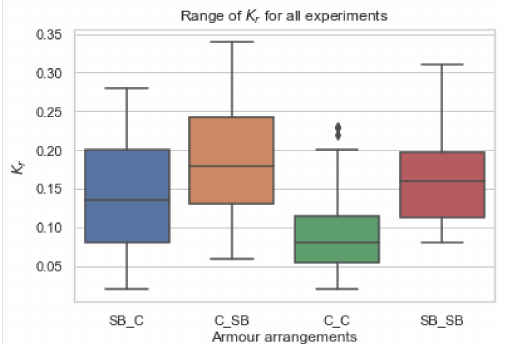
Figure 8. The range of reflection coefficients corresponding to the variations utilized.